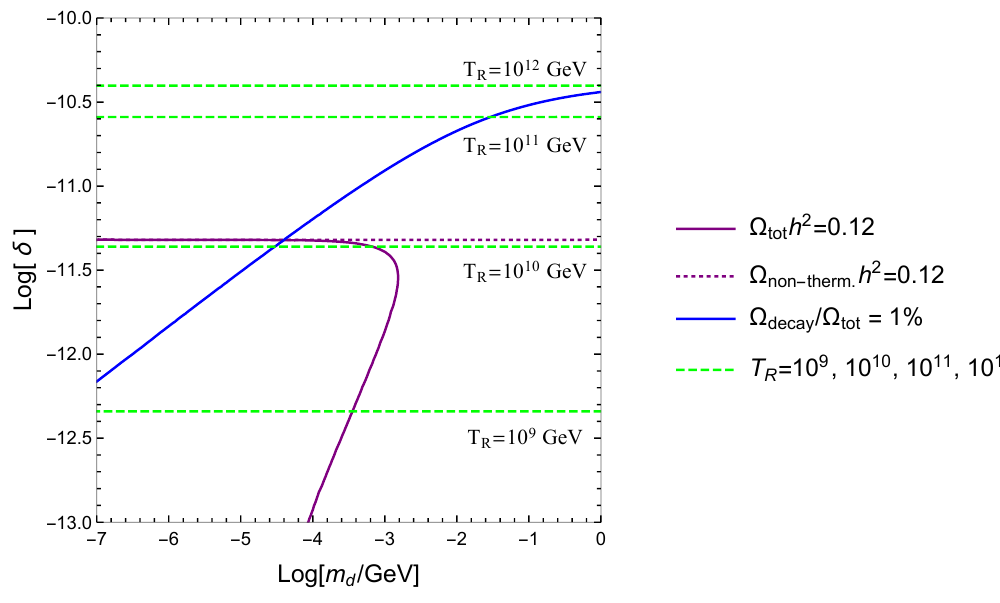
Figure 3 . In(cid:13)aton portal mixing (cid:14) as a function of the dark matter mass m d such that the scalar S d constitute the only dark matter constituent of the Universe, where we (cid:12)xed v (cid:27) = 10 16 Vev, (cid:21) (cid:27) = 0 : 1 and ( (cid:21) (cid:30) ; v (cid:30) ) = (10 (cid:0) 13 ; 20 M p ) to match with experimental measurement of the in(cid:13)ationary observables. The purple full line represent the total relic density whereas the purple dotted line stands for only the non thermal contribution to the latter. The blue line delimits the region where the non thermal contribution constitute more than 99% of the total relic density (upper part of the plot). Finally the green dashed line indicate the values of the reheating temperature T R for di(cid:11)erent values of the